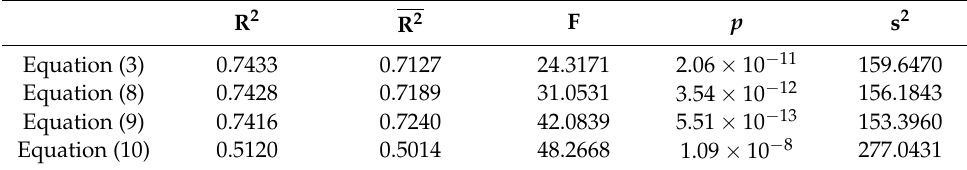
Table 4 shows the test statistics of the four regression equations: Table 4. Test